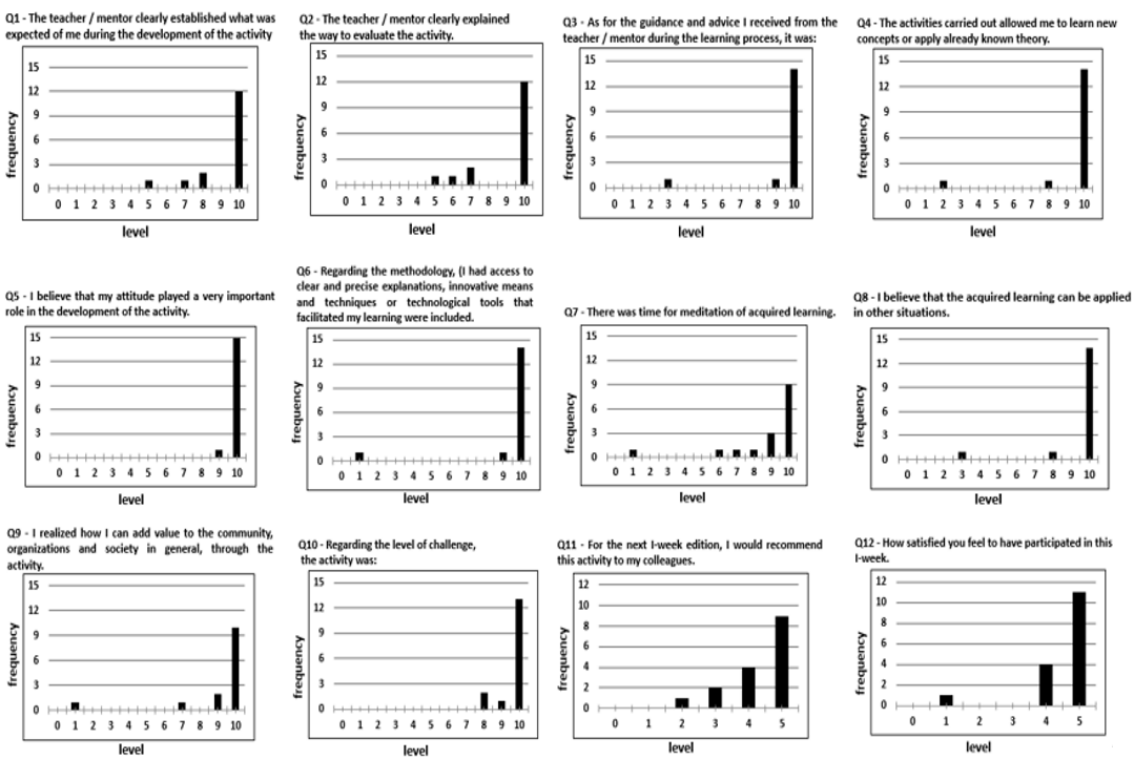
Figure A2. Frequency distribution for surveys